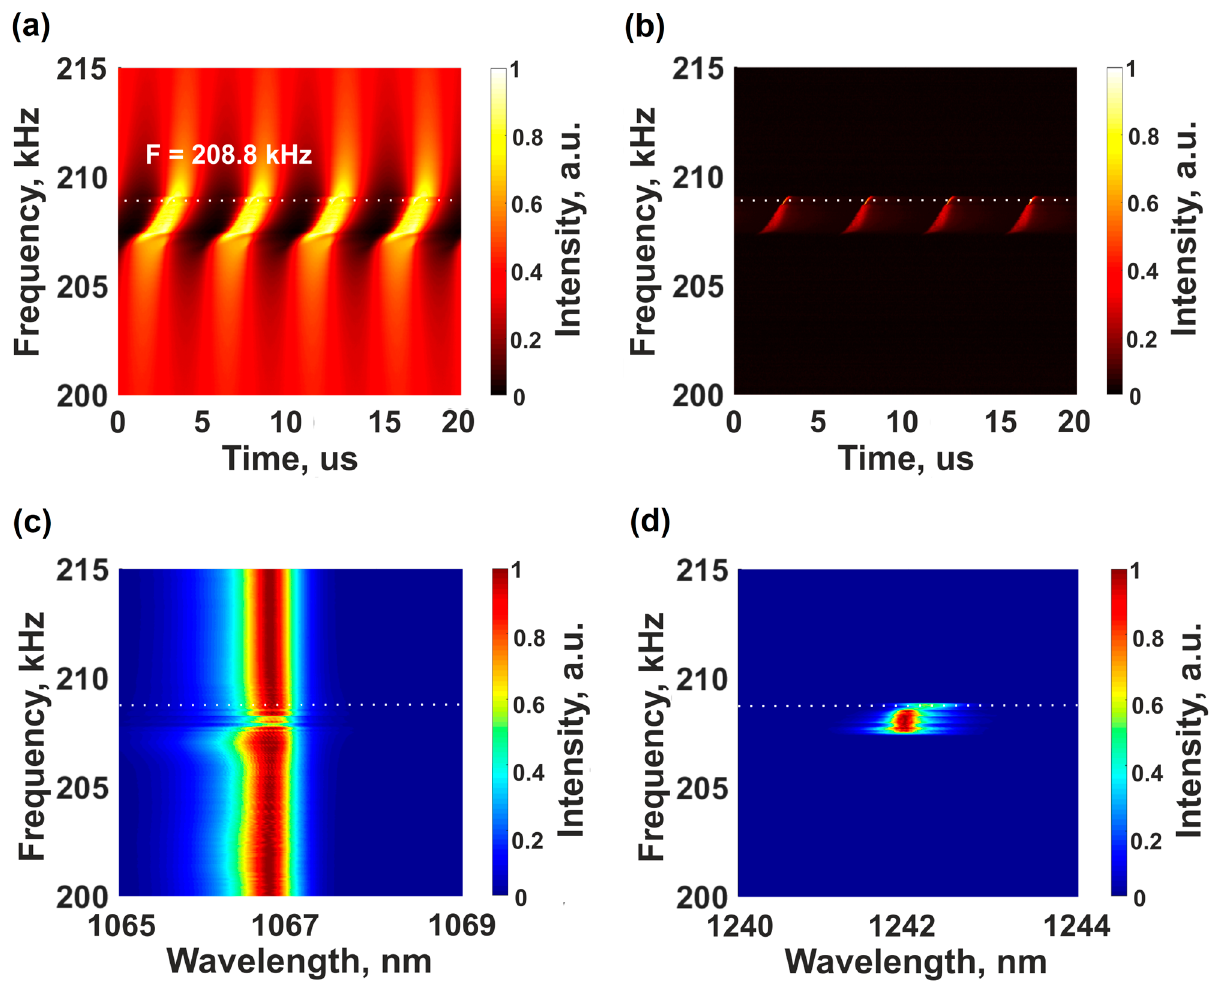
Figure 3. Evolution of temporal and spectral characteristics of laser radiation which was measured upon the modulation frequency sweep in the vicinity of the fundamental pulse repetition rate: ( a ) evolution of temporal distribution of lasing power at the fundamental wavelength (~1.07 μ m); ( b ) evolution of temporal distribution of lasing power at the Stokes wavelength (~1.24 μ m); ( c ) evolu- tion of spectral distribution of lasing power at the fundamental wavelength (~1.07 μ m); ( d ) evolution of spectral distribution of lasing power at the Stokes wavelength (~1.24 μ m). The dotted white lines indicate the frequency (F=208.8 kHz) at which the dual-wavelength pulsed lasing was further ex- amined.